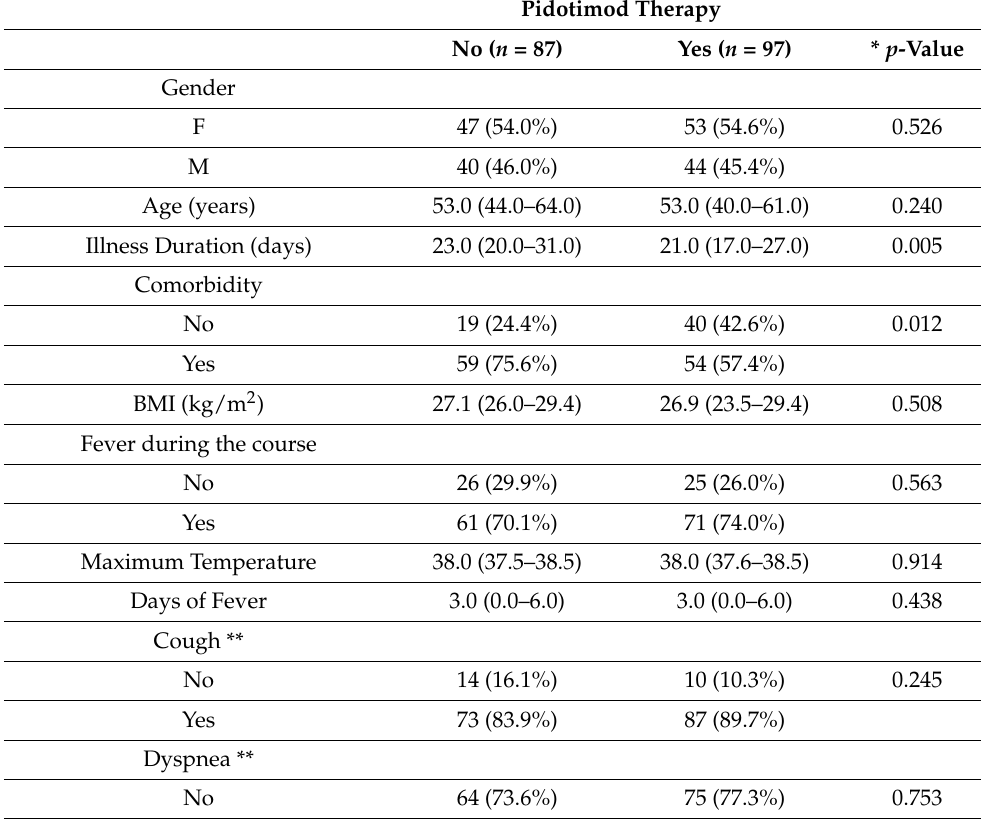
Table 2. The patients’ socio-demographic and clinical characteristics for pidotimod therapy ( n =